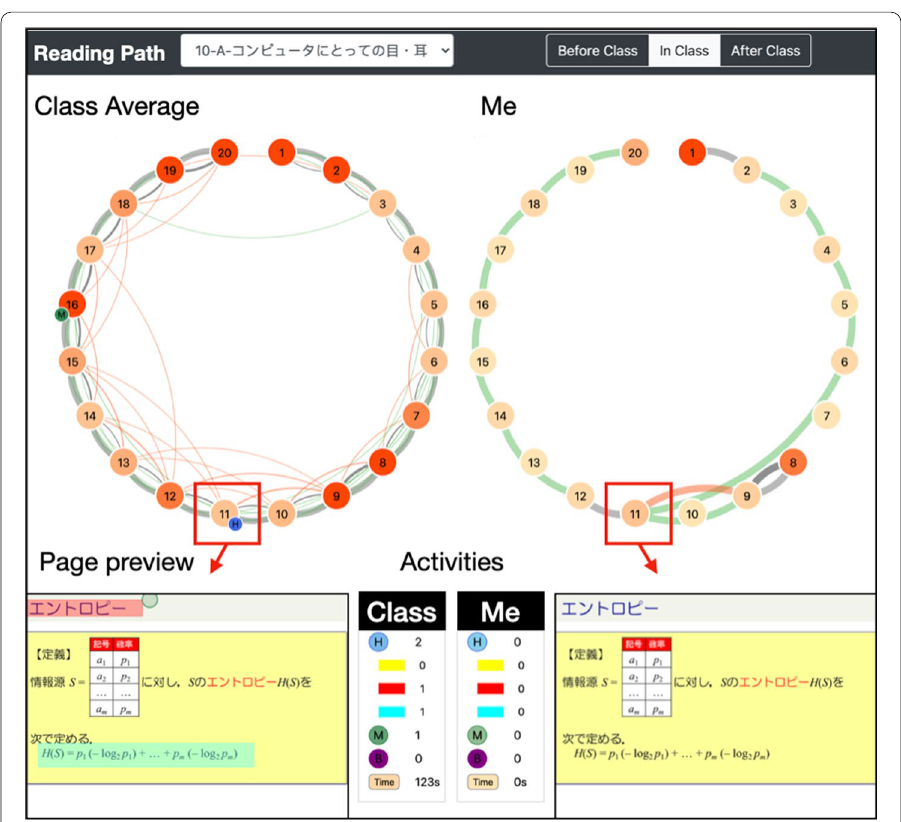
Fig. 16 The reading path dashboard